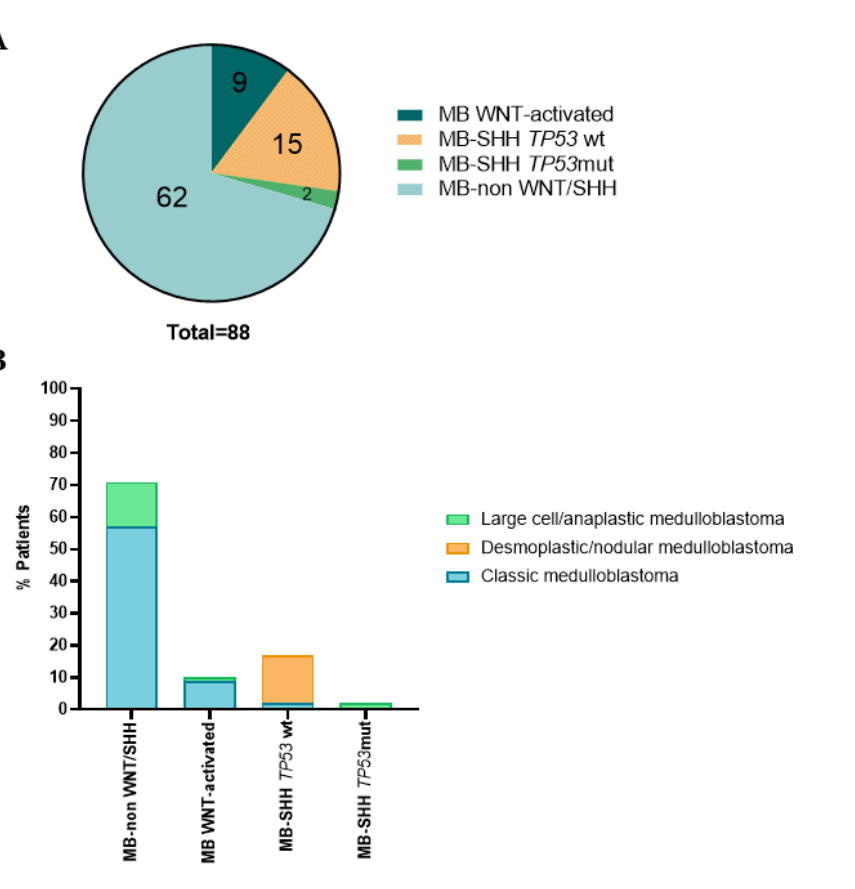
Table 1. CTNNB1 mutations found in medulloblastoma tumor samples and in our study. Amino Acid Position 1